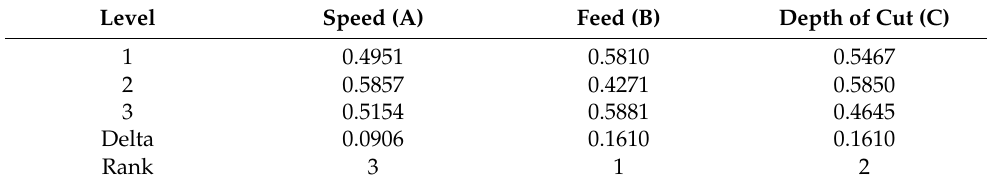
Table 10. Level mean of GRG values.